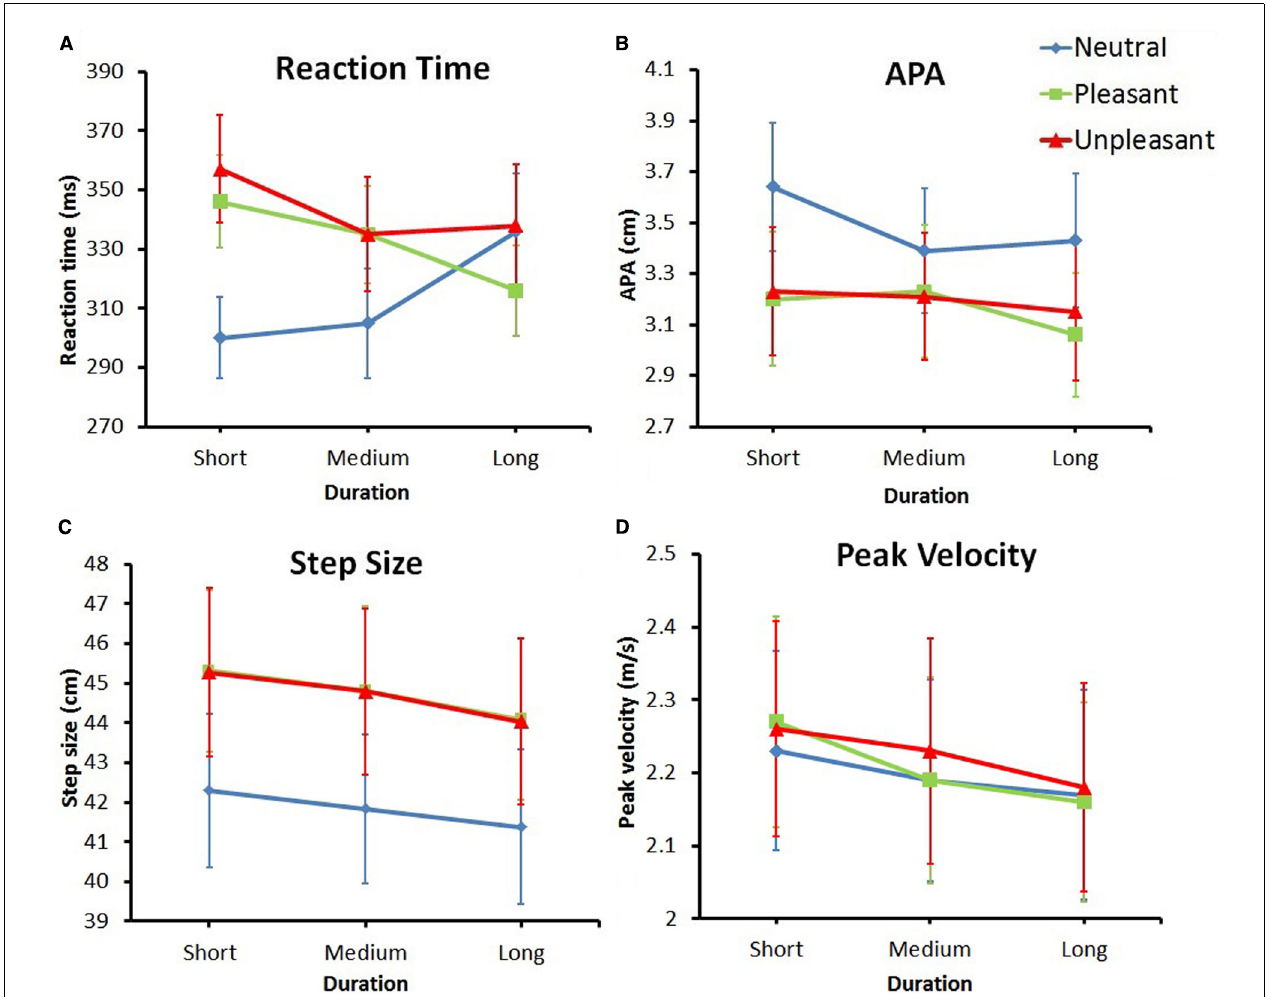
FIGURE 3 | Plotted means ( + Standard Errors) for all dependent variables. (A) Reaction time. (B) Anticipatory Postural Adjustment. (C) Step size. (D) Peak velocity.